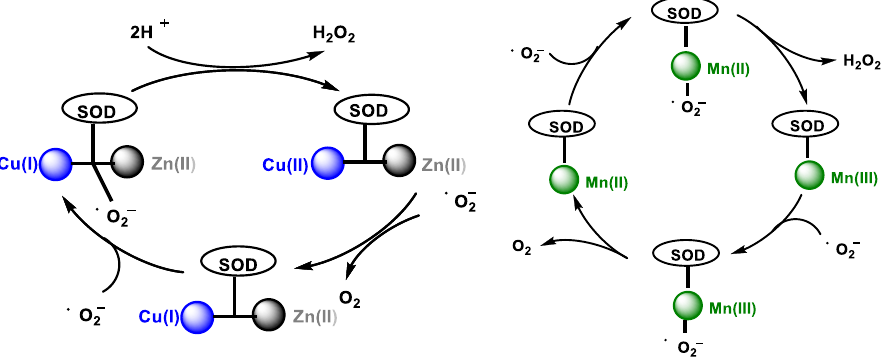
Figure 5. ( Left ): Cu/Zn SOD catalytic pathway. ( Right ): Mn SOD catalytic pathway. NADPH oxidase is an enzyme that catalyses the reduction reaction of O 2 to • O 2 − and/or H 2 O 2 using NADPH as an electron donor [21]. It was first identified in phagocytic cells of the innate immune response and is involved in the “ respiratory burst ” , generating large amounts of • O 2 − to destroy invading